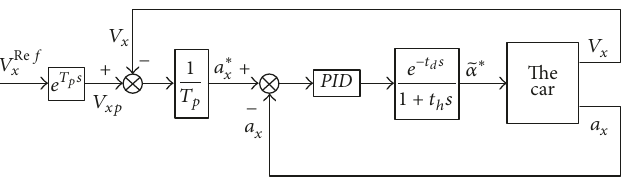
Figure 13: Longitudinal speed control strategy [18].